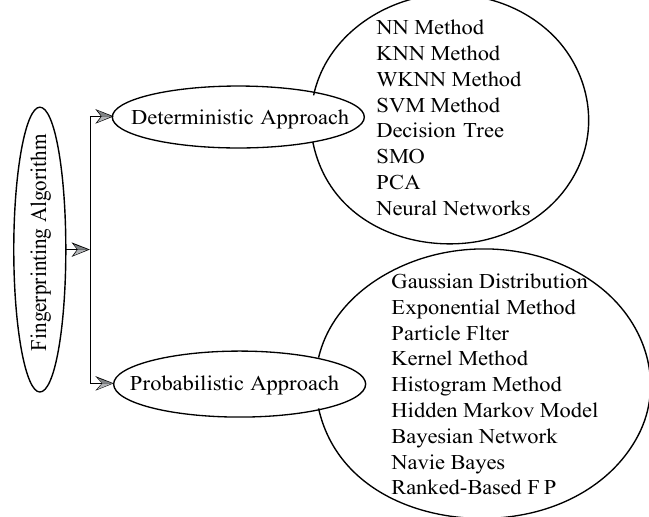
Figure 13. Illustration of the fingerprinting algorithm.